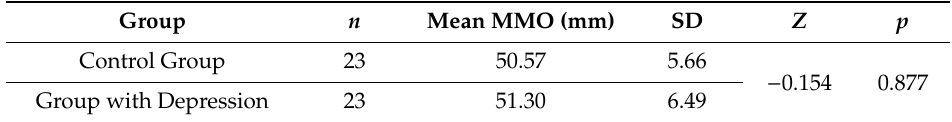
Table 2. The comparison of mean maximum mouth opening (MMO) between the group without depression (control group) and the group with depression.